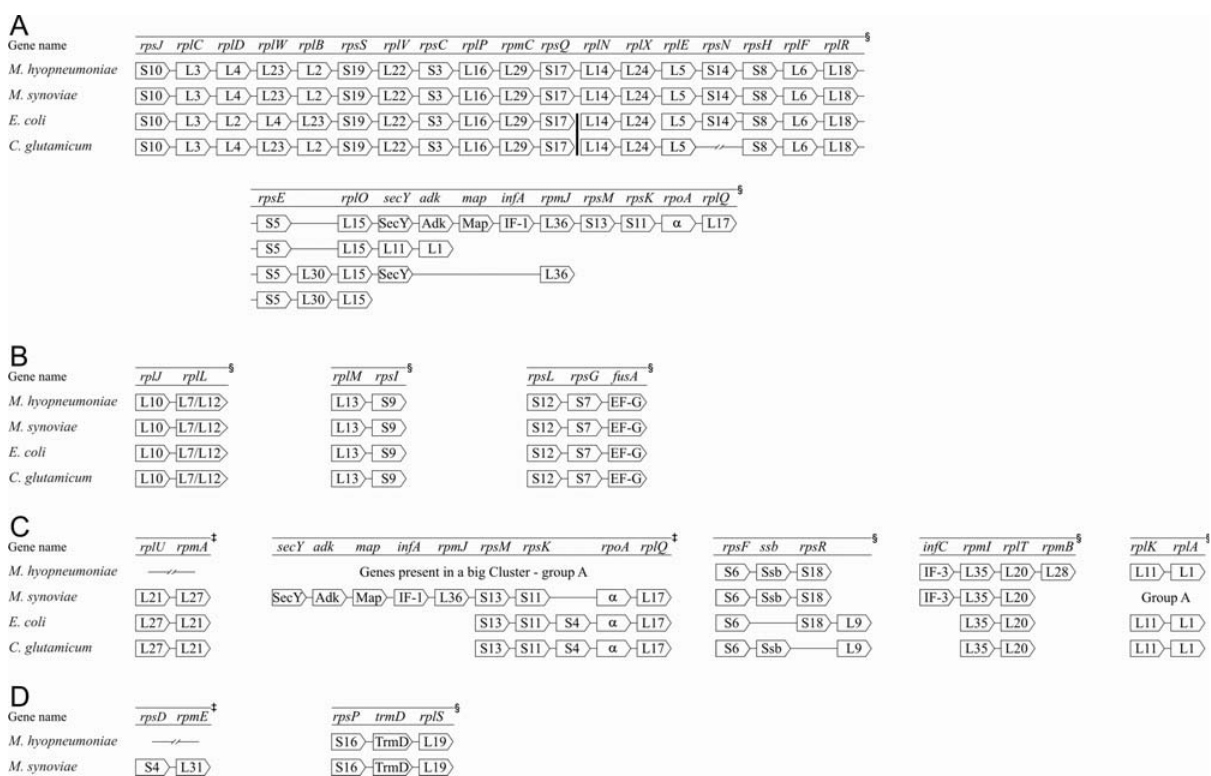
Figure 1 - Gene clusters of ribosomal proteins in Mycoplasma synoviae , Mycoplasma hyopneumoniae , Escherichia coli and Corynebacterium glutamicum . Arrows represent genes with their relative orientation in the genomes. Contiguous arrows represent adjacent genes, while interrupted lines indicatelossofproximity.ThesolidbarindicatesthelimitoftheS10and spc operonsin E.coli and C.glutamicum .Thenamesofthegeneswereobtained from M. hyopneumoniae (§) or from M. synoviae (‡) (when the name was not defined for M. hyopneumoniae ). (A) A big cluster showing differences be- tween the four organisms; (B) Clusters with identical organization in the four organisms; (C) Another cluster showing differences between the organ- isms; (D) Clusters presenting particularities in M. synoviae and M. hyopneumoniae . Abbreviations used for gene names: SecY (preprotein translocase secY subunit), Adk (adenylate kinase), Map (methionyl aminopeptidase), IF-1 (translation initiation factor IF-1), α (DNA-directed RNA polymerase subunit alpha), EF-G (elongation factor EF-G), Ssb (single-stranded DNA-binding protein), IF-3 (translation initiation factor IF-3), TrmD (tRNA (gua- nine-N1)-methyltransferase).Datafor E.coli and C.glutamicum wereretrievedfromNCBI’scompletegenomesectionandfromMartín etal.